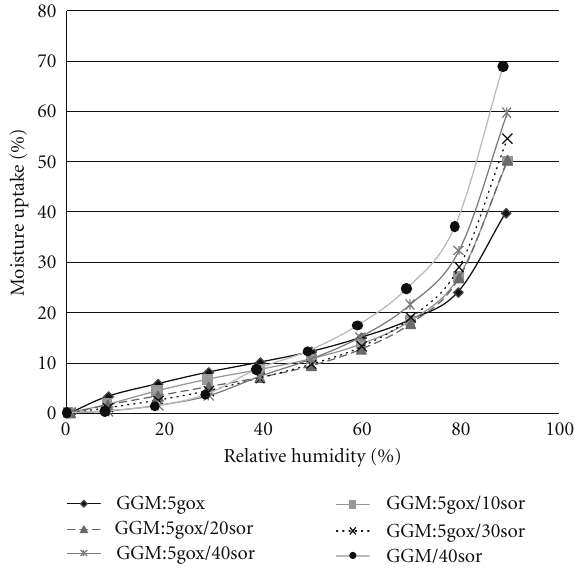
Figure 3: The water sorption isotherms of films. Sample coding as presented in Table